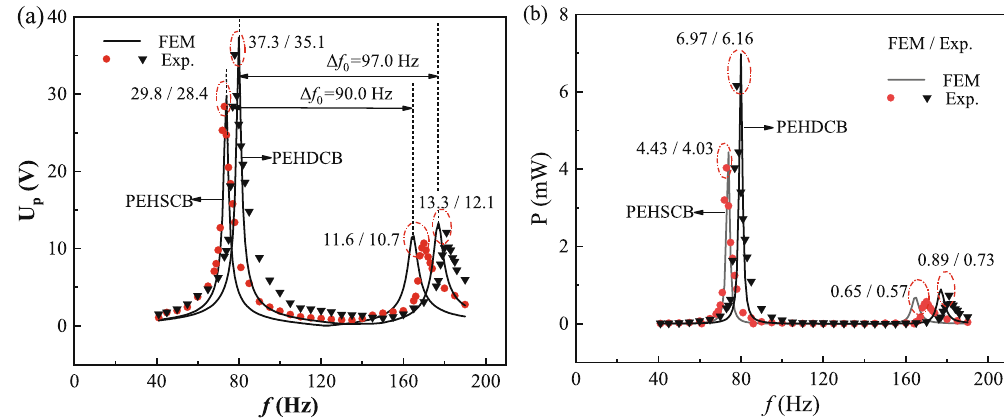
Figure 10. Effect of width splitting method on the U p - f ( a ) and P- f ( b ) curves of PEHs undergoing coupled bending-torsion vibrations.